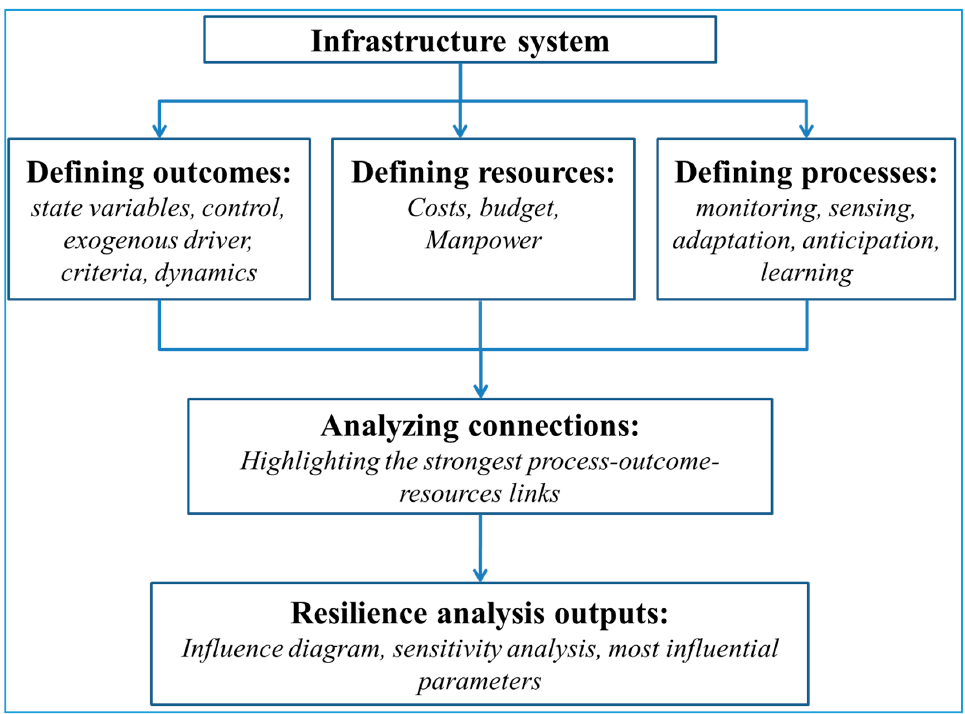
Figure 3. Combining process- and outcome-based approaches for analyzing infrastructure resilience.